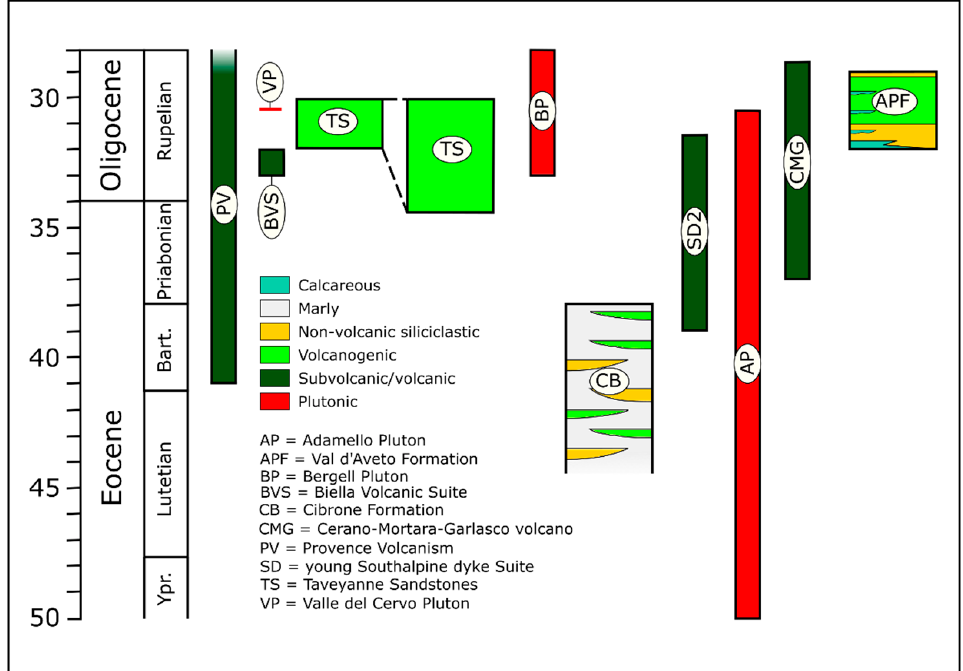
Figure 2. Magmatic manifestations and general stratigraphy of the sedimentary sequences included in the Northern Alpine Foreland Basin, Adriatic Foredeep and Northern Apennine Foredeep modified from [18] and ref. therein, limited to the Formations’ object of this review.